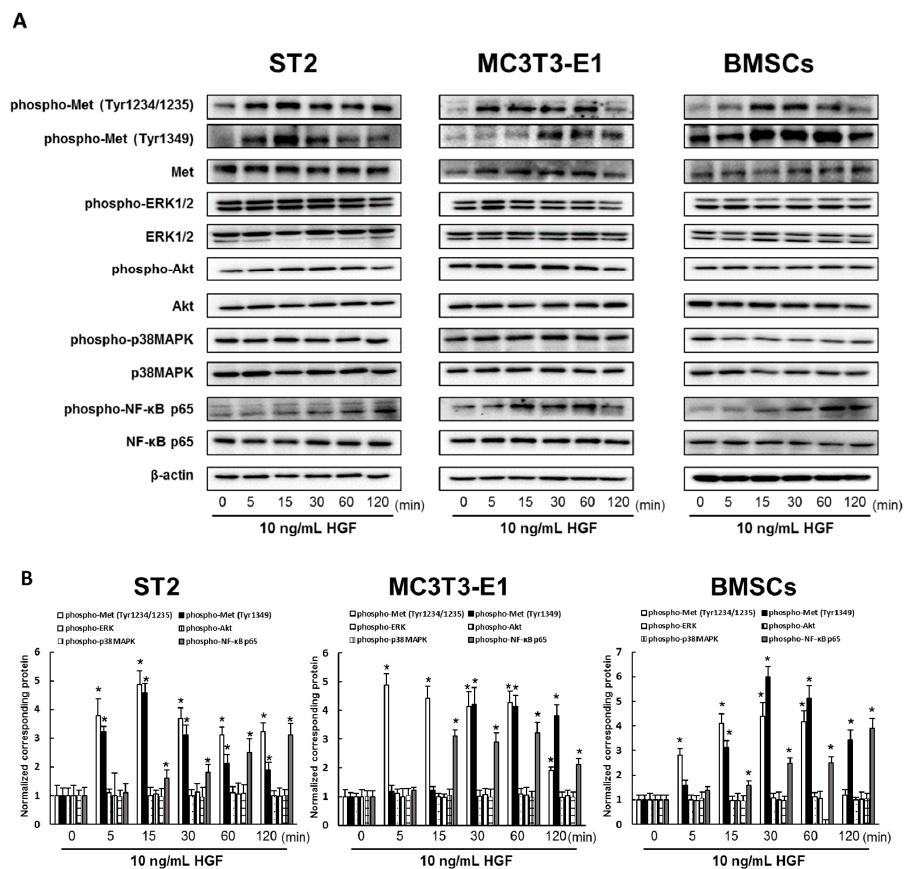
Figure 4. HGF induces the activation of the Met / NF- κ B pathway in BMSCs and osteoblasts. ( A ) ST2 cells, MC3T3-E1 cells, and mouse BMSCs were incubated with 10 ng / mL HGF. At various time points, cell